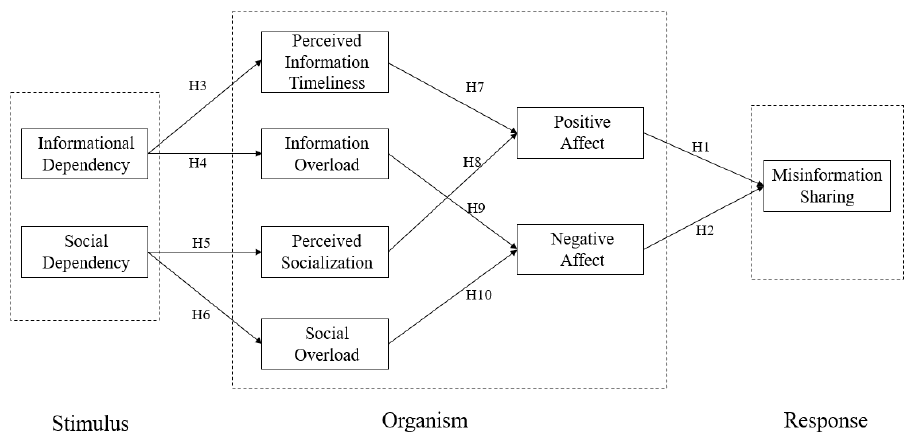
Figure 1. Research